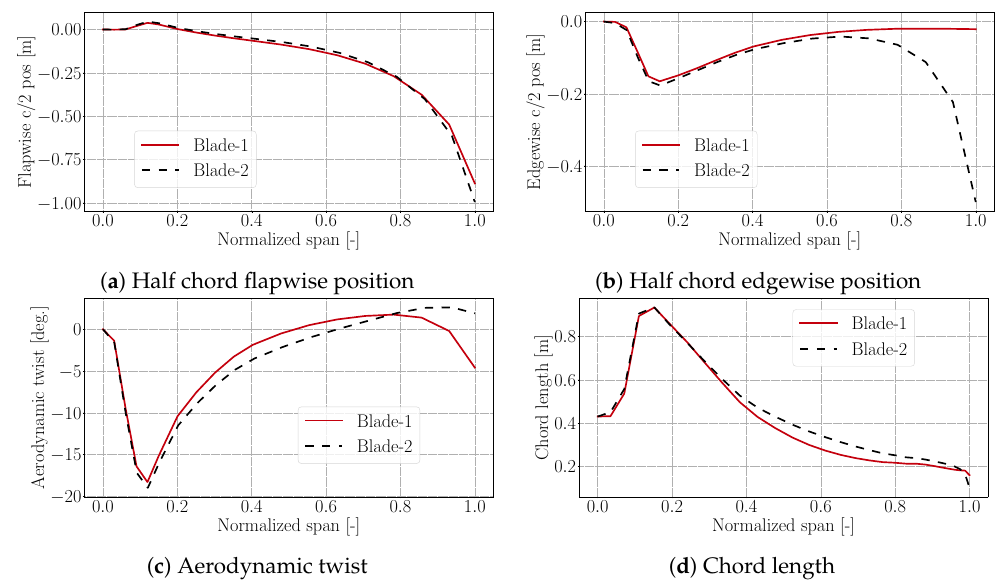
Figure 3. Half chord (c/2) flapwise ( a ), edgewise ( b ) positions, aerodynamic twist ( c ), and chord length ( d ) along the normalized span for both blade designs.